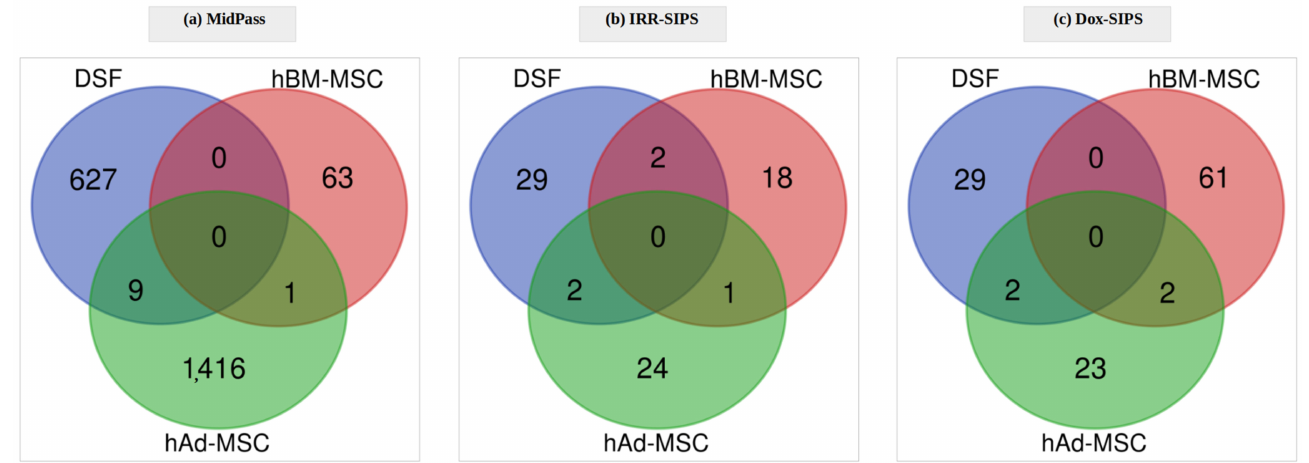
Figure 6. Differentially methylated positions shared among the three cell types after ( a ) a middle number of passages (MidPass), ( b ) irradiation-induced senescence (IRR-SIPS) and ( c ) doxorubicin- induced senescence (Dox-SIPS).